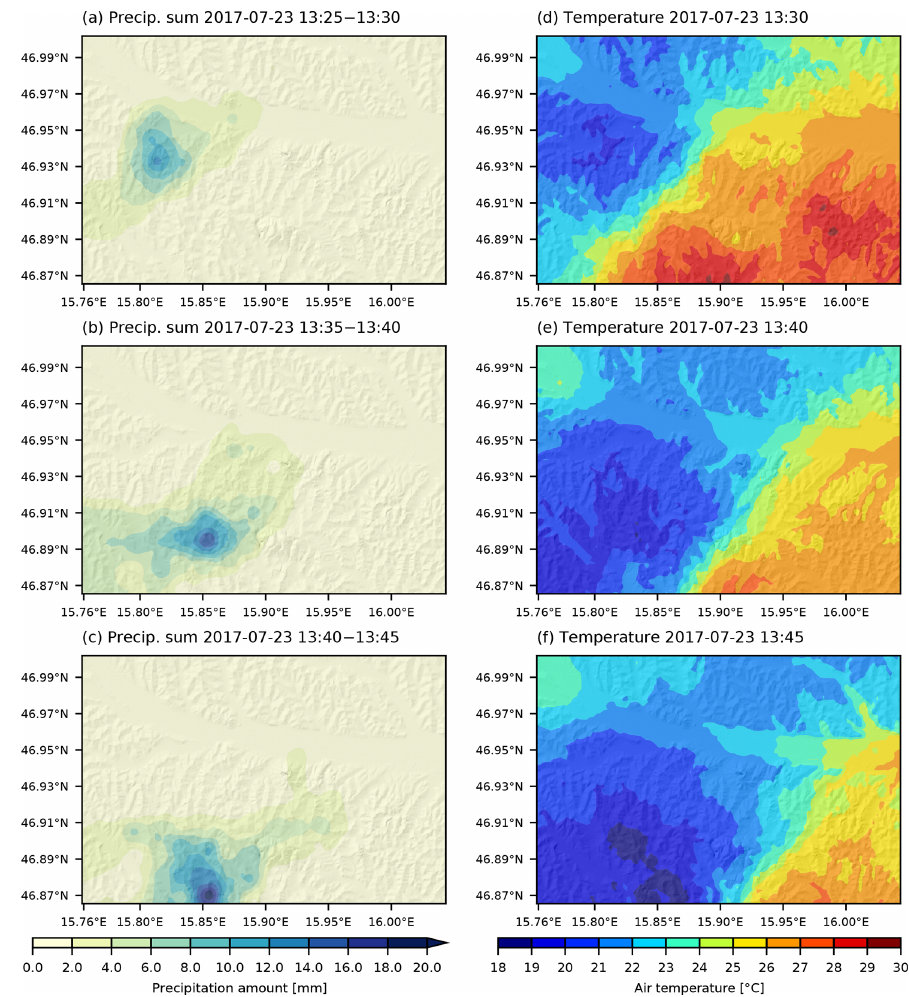
Figure 5. Gridded fields of 5min precipitation sums (a, b, c) of a strong local-scale thunderstorm cell moving through the western part of the WegenerNet Feldbach Region and associated temperature field data (d, e, f)